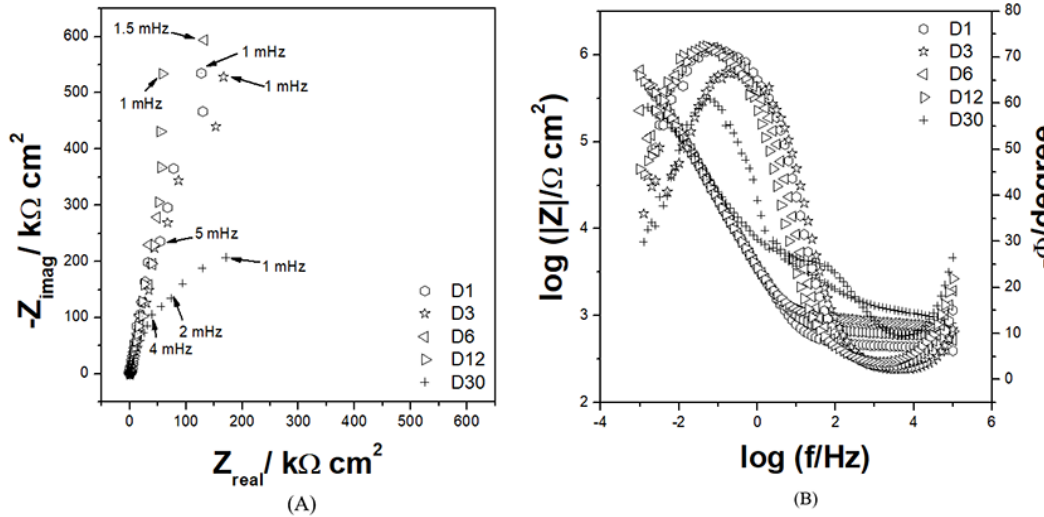
Figure 9. Impedance diagrams for HA sample in non-aerated and unstirred Hanks' solution with 4.2 g L -1 BSA for 30 days of immersion at 37 ºC: (A) complex plane plots; (B) Bode - phase angle vs . log f and impedance modulus vs . log f